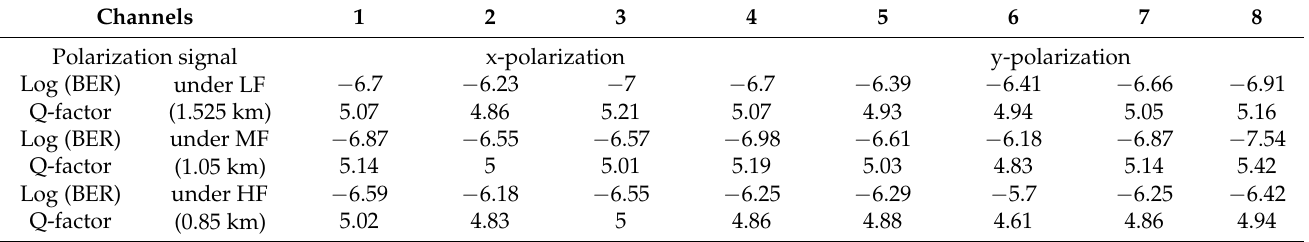
Table 4. log (BER) values and Q-factors of eight channels of FSO-PDM/PV-OCDMA system under different fog conditions and propagation